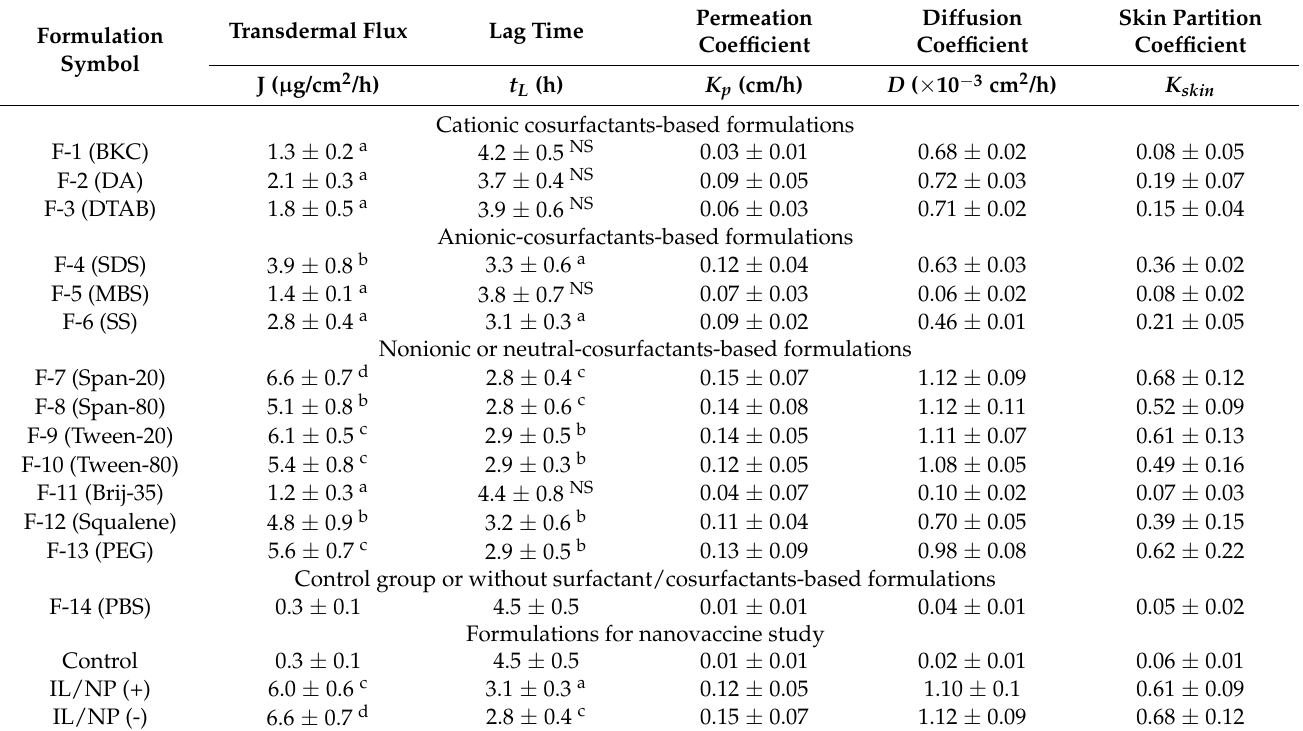
Table 2. In vitro skin permeation kinetics of LCNDFs and the nanovaccine calculated using lag time